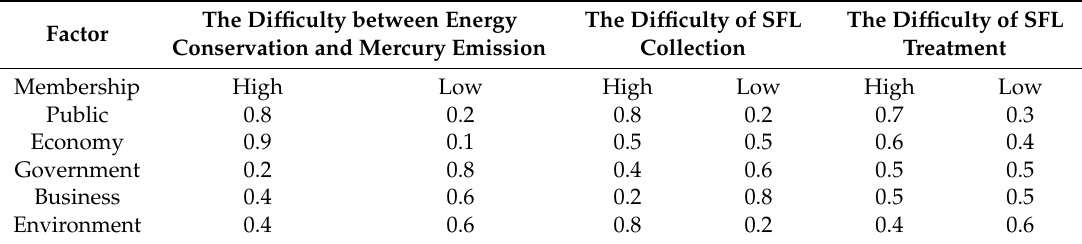
Table 1. Membership of